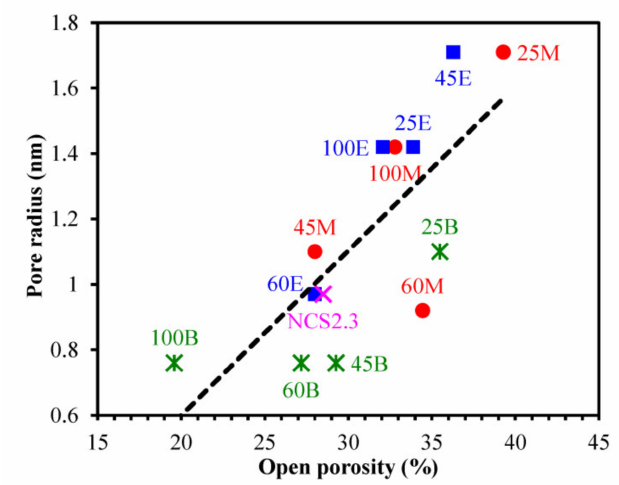
Figure 9. Pore radius of studied organosilicate films versus open porosity (ellipsometric porosimetry data). In this Figure: M—methylene bridge (BTESM), E—ethylene bridge (BTMSE), B—1,4-phenylene bridge (BTESB) and preceding digits indicate the alkylenesiloxane content in the matrix precursor in mol%. The data point of NCS2.3 low- k film is included for